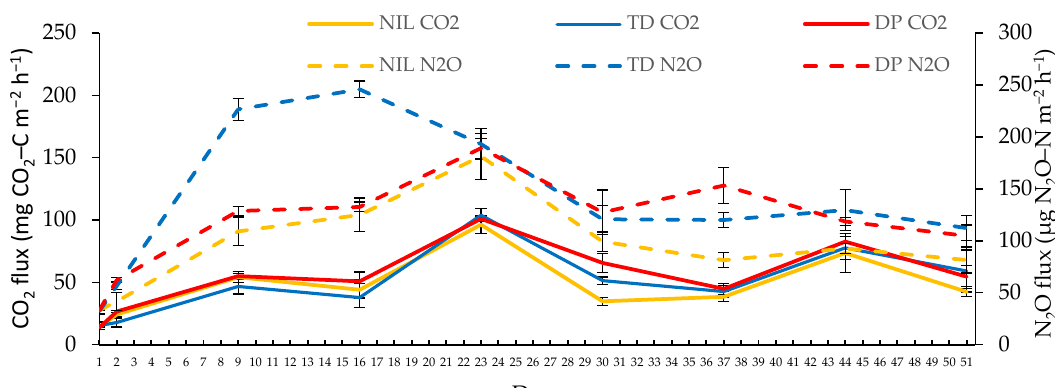
Figure 1. N 2 O–N and CO 2 –C emissions from non-fertilized soil (NIL) and soils fertilized with ammonium nitrate: top dressing (TD) and deep placement (DP).